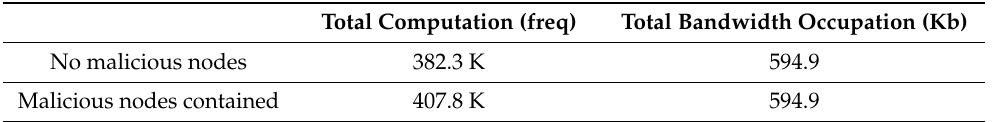
Table 4. The performance of the PBFT algorithm.